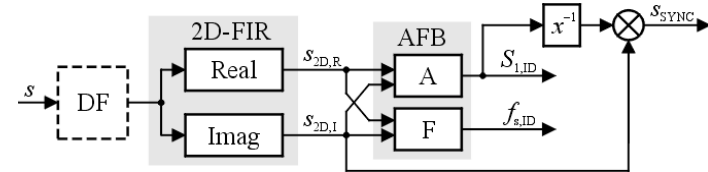
Figure 4. Block diagram of the identification algorithm.